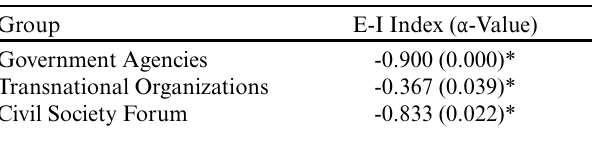
Table 2 . E-I index showing homophily for the three main organizational types (national organizations, transnational organizations) and the NGOs of the Civil Society Forum; * = significant at the 0.05